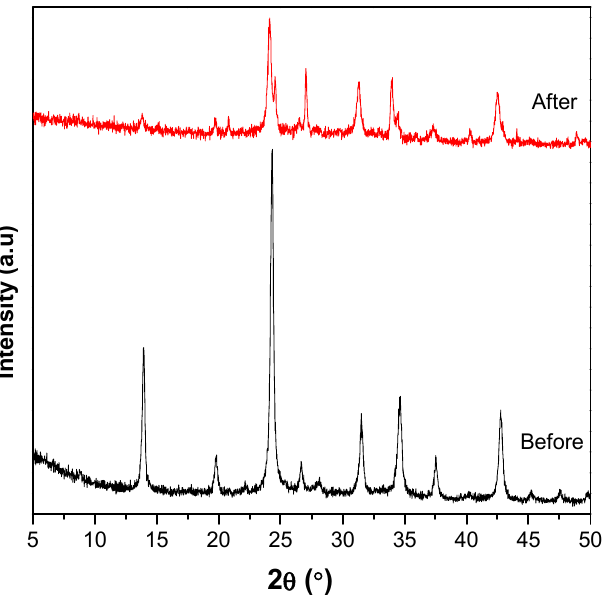
Figure 11. XRD analysis of S80H9 after Pb 2+ adsorption.